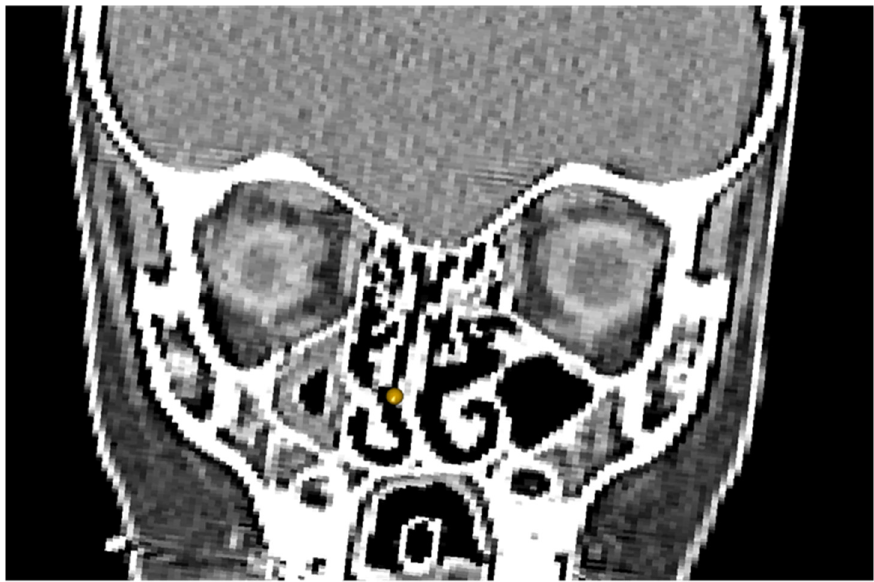
Figure 2. Coronal slice of a male specimen showing a landmark placed on the most laterally deviated point of the nasal septum. Image created using Avizo 9.0 (FEI visualisation). Interslice distance 0.5 mm.